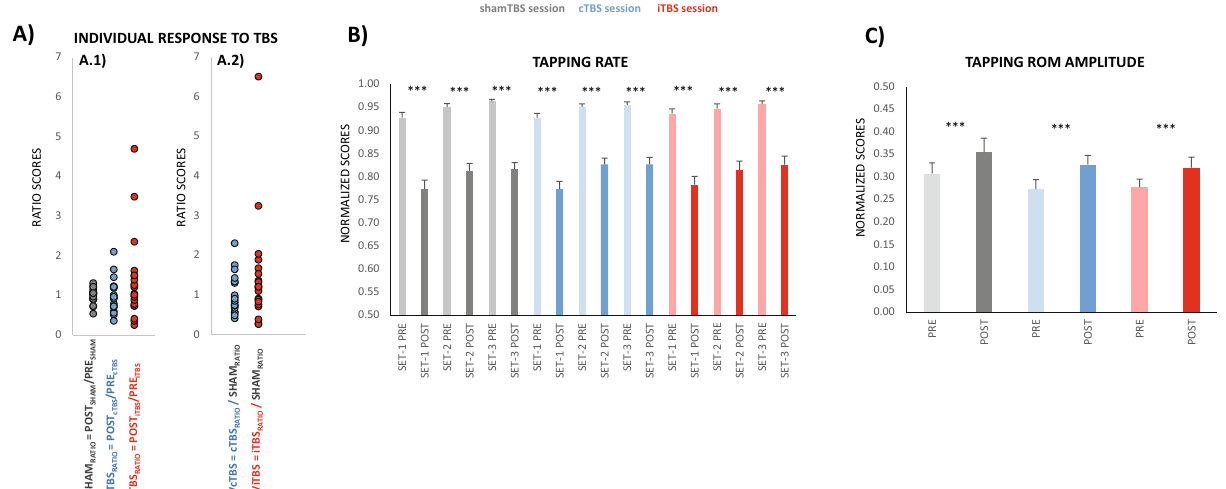
Figure 3. Effects of M1-TBS on fatigue expressions for maximal FT rate and FT ROM. ( A ) Individual responses to TBS; ( A1 ) shows the individual scores of the ratio calculated with MEP amplitude PRE and POST TBS for each session (SHAM RATIO , cTBS RATIO and iTBS RATIO ). MEP amplitude scores (mean across participants) at PRE did not differ between sessions (ANOVA p = 0.33; 1.8 mV SE 0.3, 1.8 mV SE 0.3, 1.4 mV SE 0.2, respectively). ( A2 ) shows the individual scores of the grand ratios (cTBS RATIO /SHAM RATIO and iTBS RATIO /SHAM RATIO ). These scores indicate each individual response to cTBS and iTBS compared to shamTBS and were introduced in ANOVA as covariables to test the aftereffects of TBS on fatigue responses. ( B ) Maximal FT rate and ( C ) FT ROM amplitude at PRE and POST after different TBS protocols; cTBS and iTBS did not produce different responses compared to shamTBS for any variable, and this effect was not different for individual responses to TBS. **p ≤ 0.01, ***p ≤ 0.001. The y-axis unit score values for ( B ) and ( C ) are shown in Table 1.